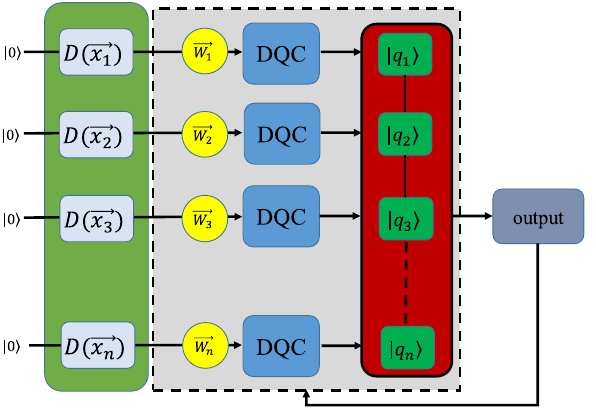
Figure 1. A quantum circuit is composed of an input layer (for encoding data), an intermediate layer (for processing data), and an output layer (for providing output signal). The classical data can be encoded into quantum states by the action of the displacement operator on the vacuum state D ( x ) | 0 � = | x � . Indeed, the i -th signal � x i = ( x 1 , x 2 , x 3 ) is encoded in the initial state of the i -th DQC. The processing unit constitutes